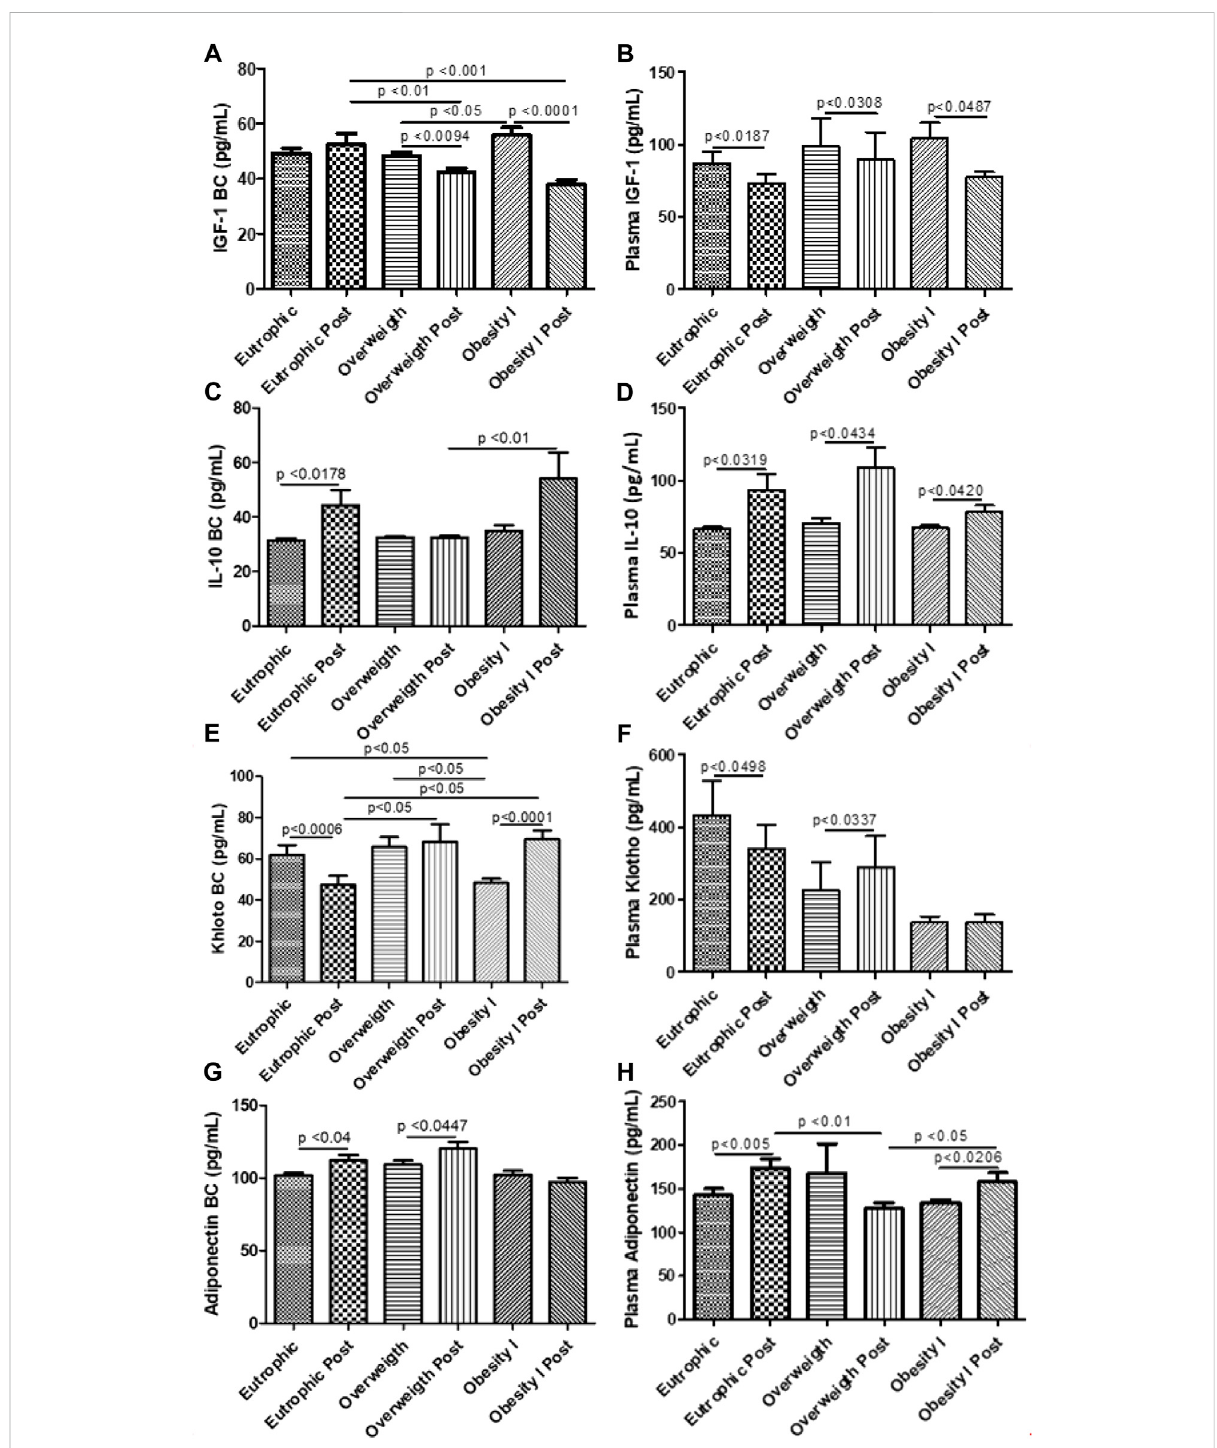
FIGURE 5 Effects of combined training on pulmonary and systemic fi brotic biomarkers. Figure 5A shows the pulmonary levels of IGF-1; Figure 5B the plasma levels ofIGF-1;Figure 5C thepulmonary levels of theanti-in fl ammatory cytokine IL-10; Figure 5Dtheplasma levels of theanti-in fl ammatory cytokineIL-10;Figure5Ethepulmonarylevelsofanti-in fl ammatoryandanti- fi broticproteinKlotho;Figure5Ftheplasmalevelsofanti-in fl ammatory and anti- fi brotic protein Klotho; Figure 5G the pulmonary levels of the anti-in fl ammatory adipokine adiponectin; and Figure 5H the plasma levels of the anti-in fl ammatory adipokine adiponectin. Paired t -test was performed to compare the pre- and post-effects of rehabilitation (i.e., eutrophic non-obese pre x eutrophic non-obese post; overweight pre x overweight post; obesity I pre x obesity I post). A p < 0.05 was considered statistically signi fi cant. These data presented parametric distribution and were additionally evaluated using one way ANOVA followed by the Newman – Keuls test for multiple comparisons among the